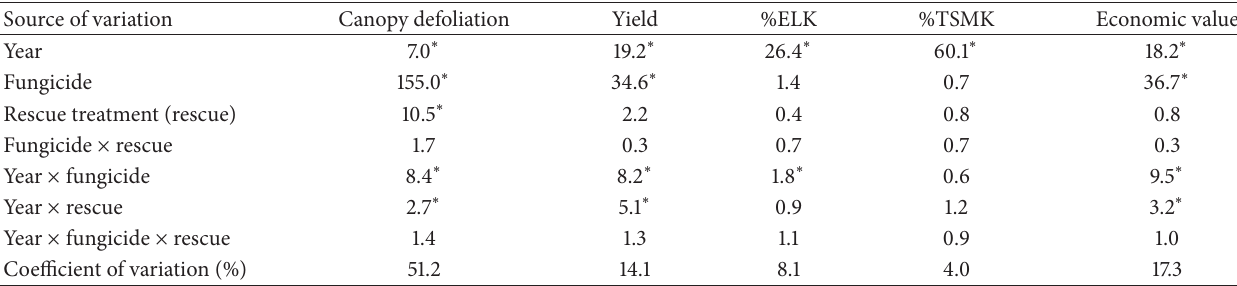
Table 11: Analysis of variance ( 𝐹 -value) for percent canopy defoliation, pod yield, percentages of extra large kernels (%ELK) and total sound mature kernels (%TSMK), and economic value for the cultivar Gregory as influenced by the interaction of fungicide regime and late-season rescue application of fungicides for experiments conducted from 2005 to 2012.